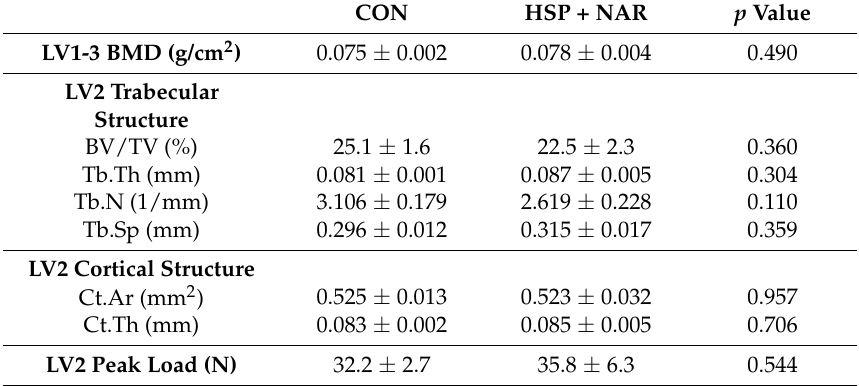
Table 3. Ex vivo bone mineral density (BMD), structure and peak load of the lumbar vertebra (LV) in 6-month-old female CD-1 mice whose mothers were exposed to control (CON) or 0.5% hesperidin (HSP) + 0.25% naringin (NAR) diets through pregnancy and lactation. CON HSP + NAR p Value LV1-3 BMD (g/cm 2 ) 0.075 ± 0.002 0.078 ± 0.004 0.490 LV2 Trabecular Structure BV/TV (%) 25.1 ±